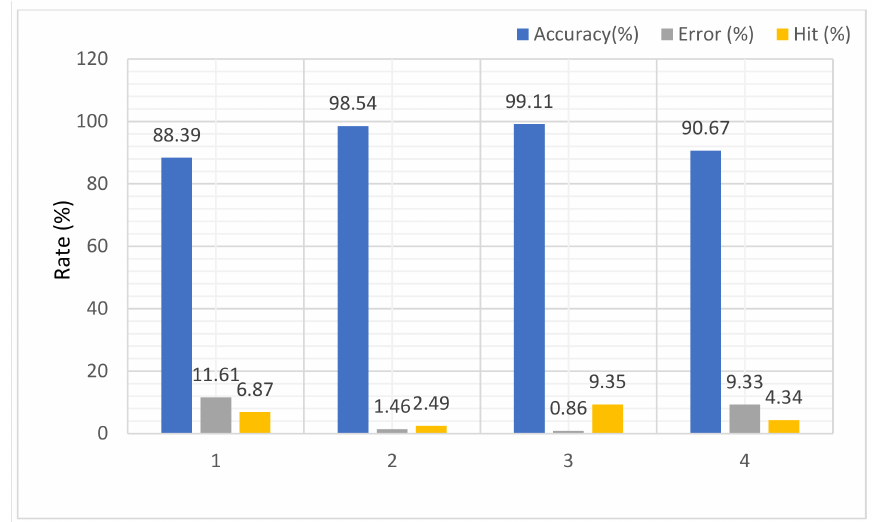
Figure 14. Performance report for Instagram